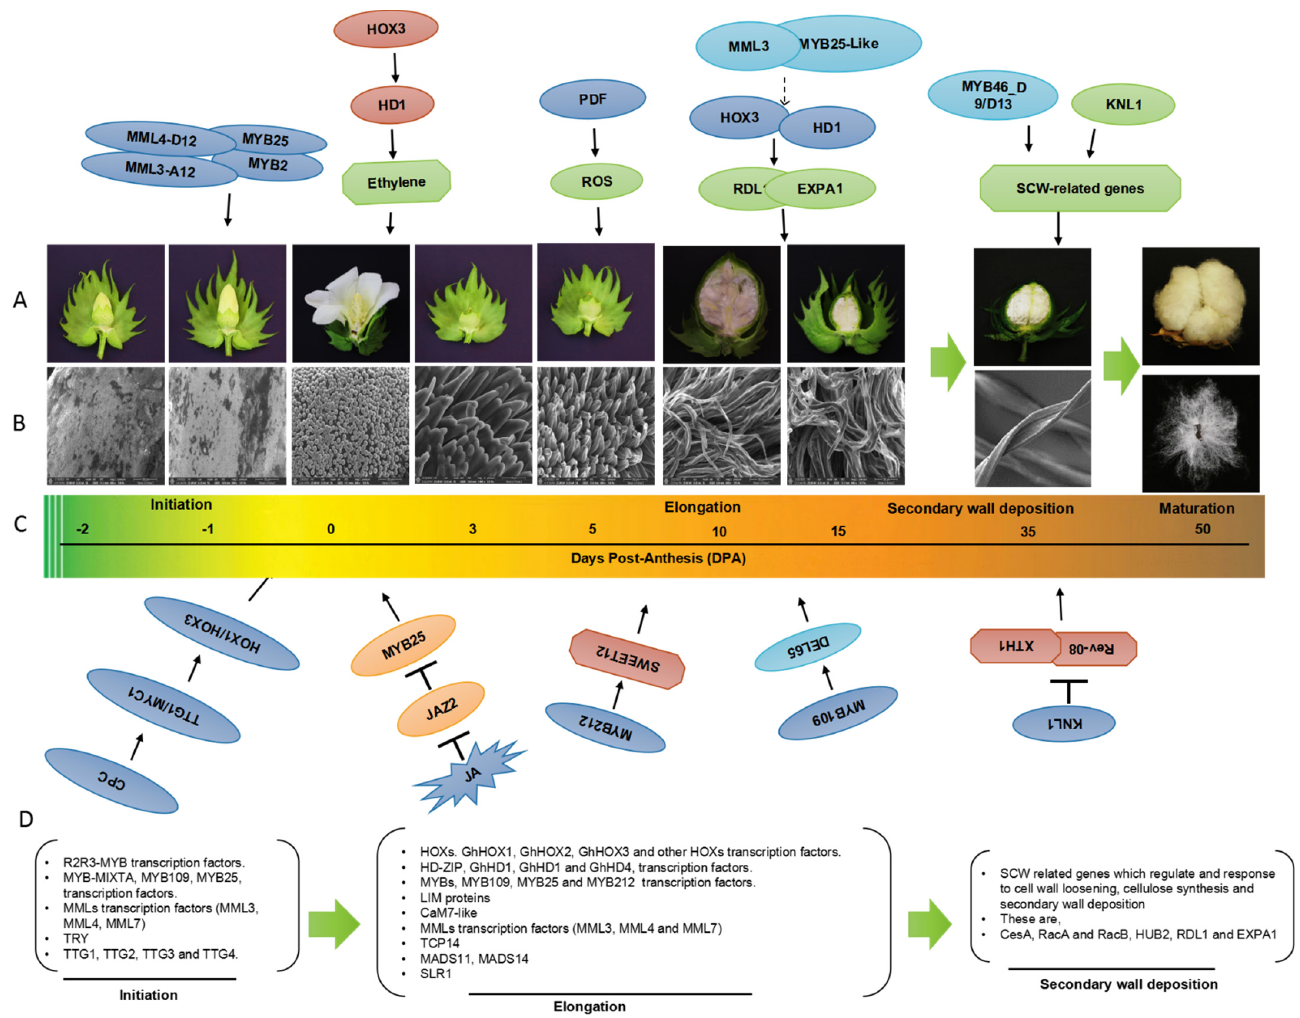
Figure 1. Role of TFs in different stages of cotton fiber development. ( A , B ) Boll and fiber development. ( C ) Fiber developmental stages include initiation, elongation, secondary wall biosynthesis, and maturation. ( B ) Scanning electron microscope (SEM) images from -2 DPA (ovule fiber initiation) to 35 DPA (fiber development completion). SEM scale = 100 μ m. ( D ) Key TFs are involved in the regulation of cotton fiber development.